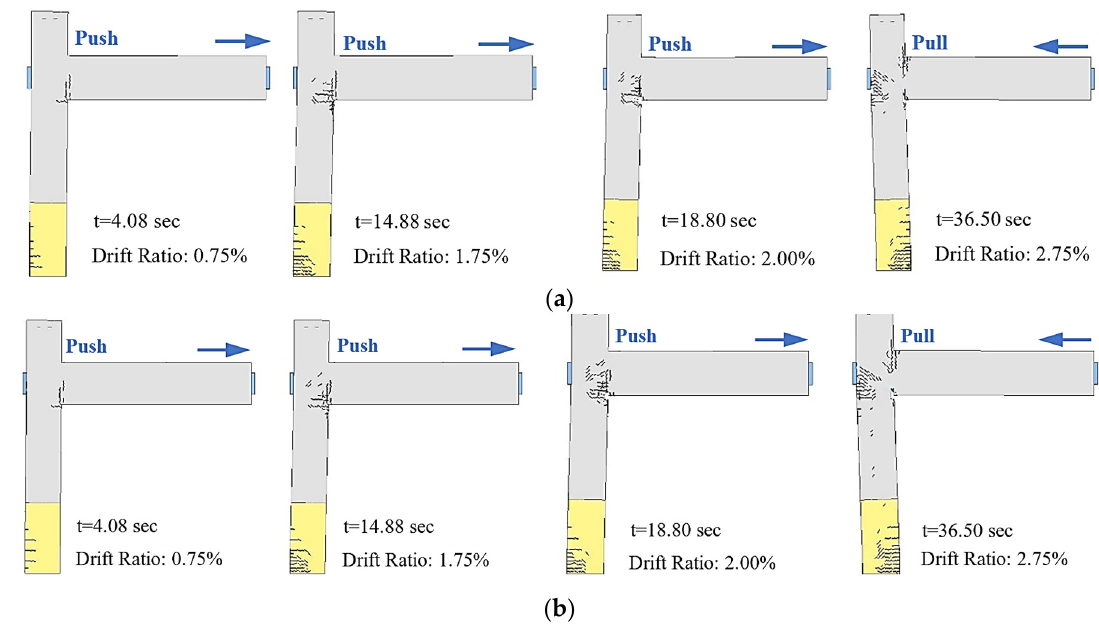
Figure 13. Crack patterns of frames at drift ratio of 1.75%: ( a ) HI-C25 model; ( b ) tested HD frame; ( c ) LI-C25 model; ( d ) tested LD frame.